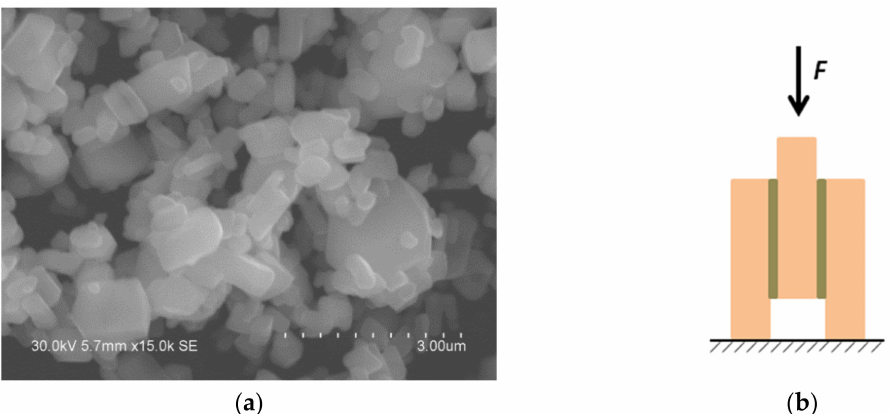
Figure 2. ( a ) Morphology of the synthesized Ag 2 C 2 O 4 particles (Scanning Electron Microscopy (SEM) image); ( b ) schematic of the assembly used for shear strength measurements (stacks joined with and without a brazing layer were tested using the same sample